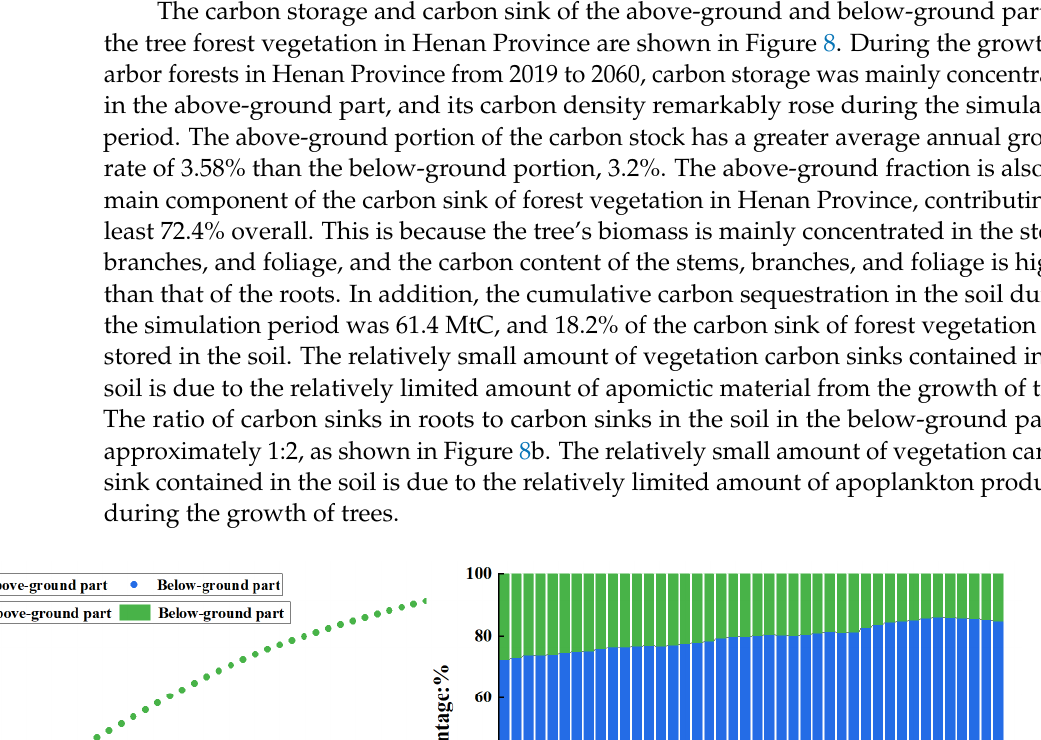
Figure 7. All arborvitae forests’ carbon density and carbon sink in Henan Province, 2019–2060.